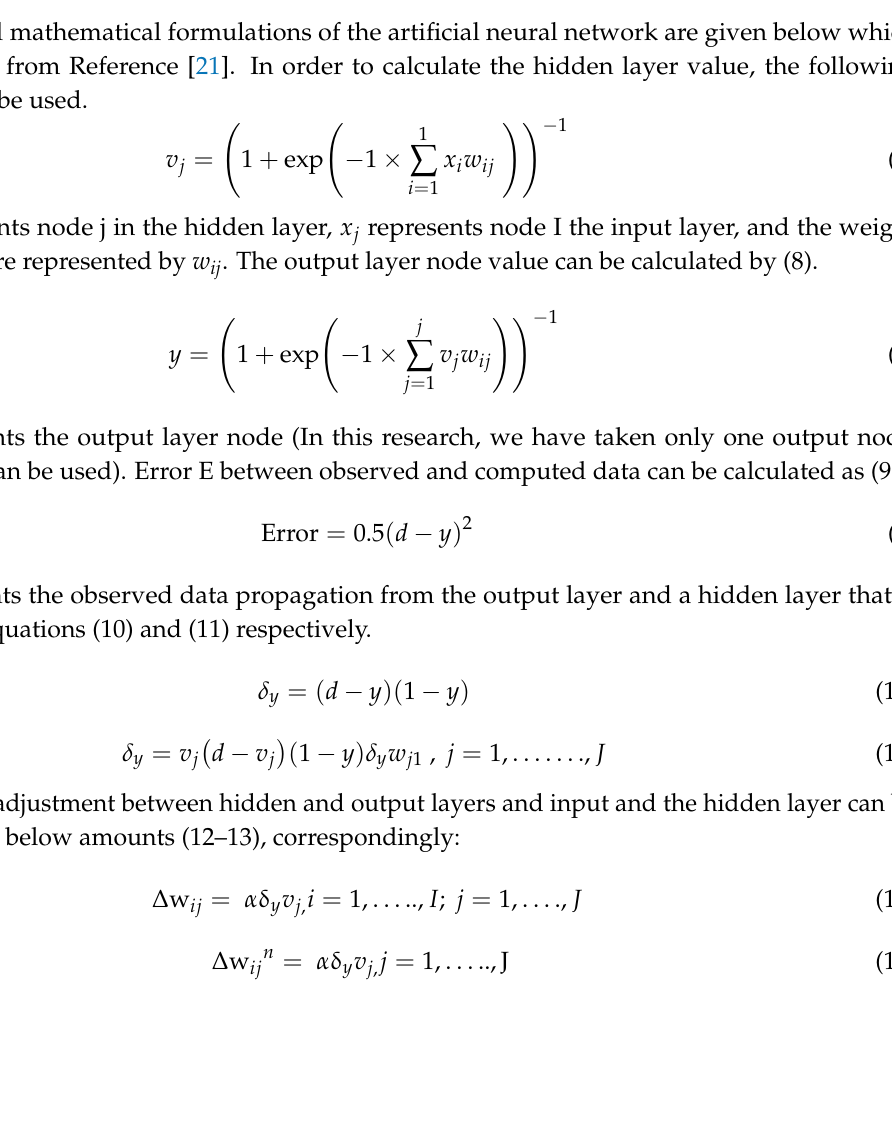
Figure 5. Structure of model M2 for eight